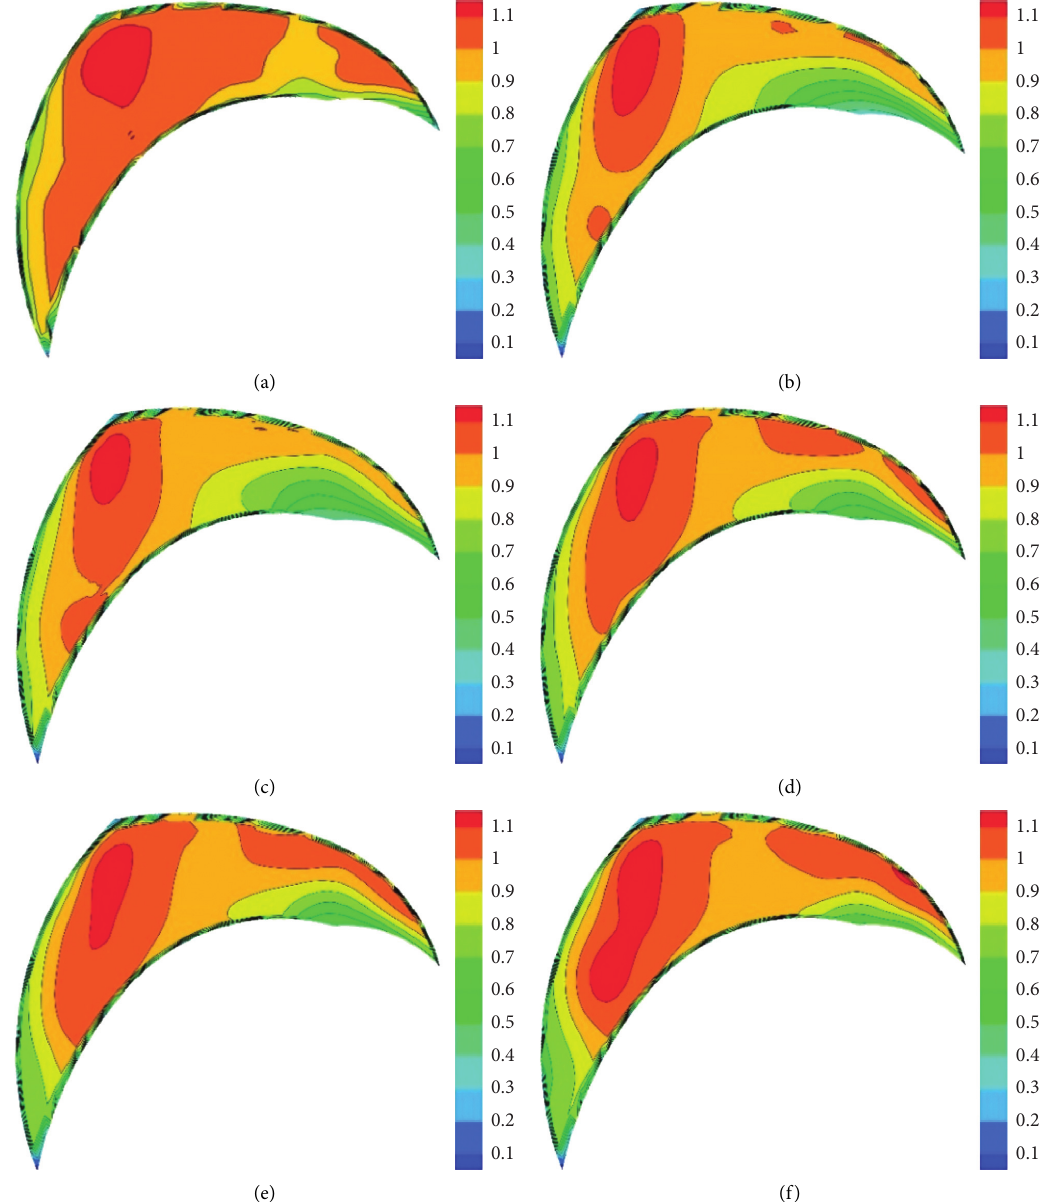
Figure 6: Distribution of slip factor in flow channel: (a) 1.2 Q BEP , (b) 1.0 Q BEP , (c) 0.8 Q BEP , (d) 0.6 Q BEP , (e) 0.1 Q BEP , and (f) 0.2 Q BEP